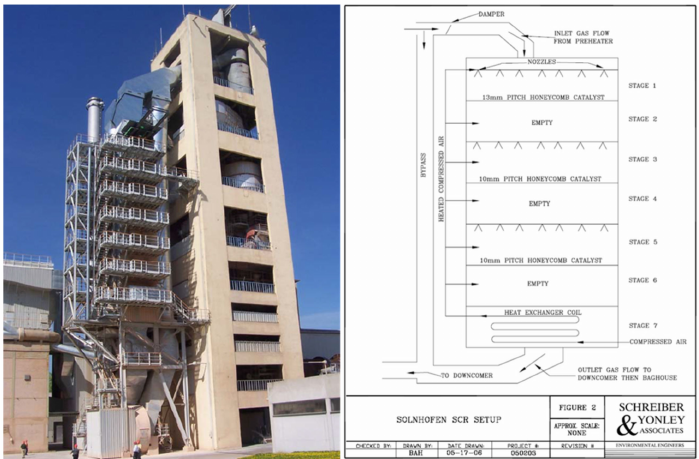
Figure 12. SCR Reactor in Solnhofen (reprinted from [33] under the Creative Commons Attribution 4.0